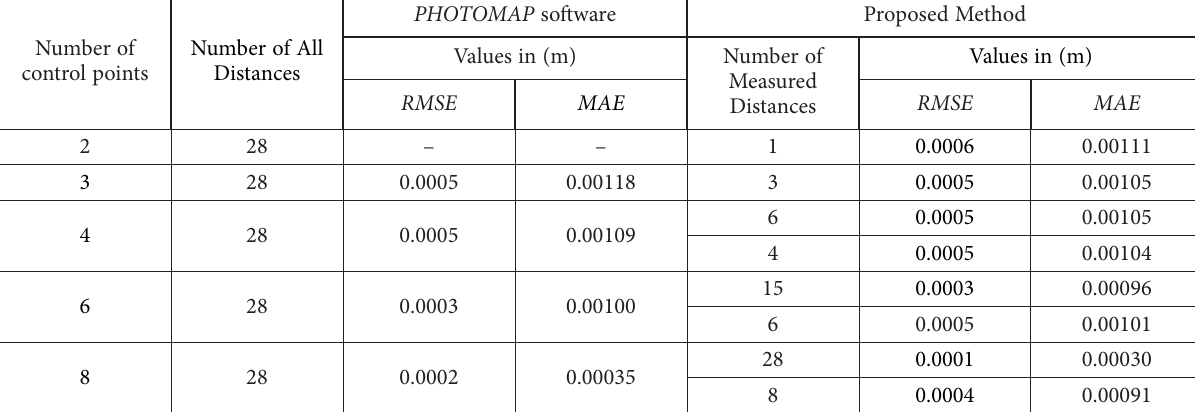
Table 5. The results of the proposed method compared to conventional method (case of close range photogrammetry) PHOTOMAP Number of Number of All control points Distances